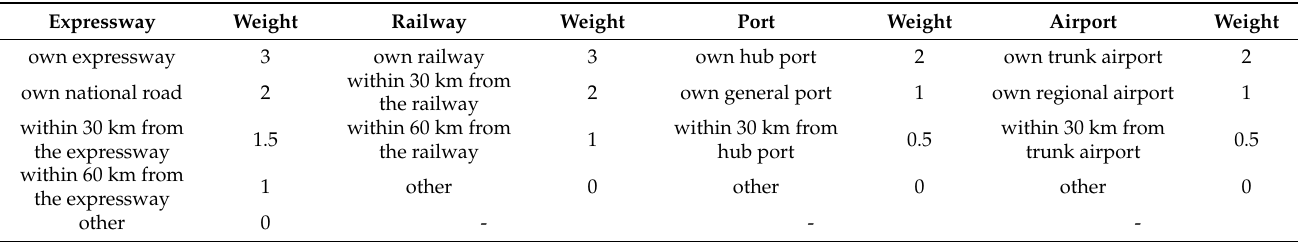
Table 2. Indicator weight of influence degree of traffic trunk